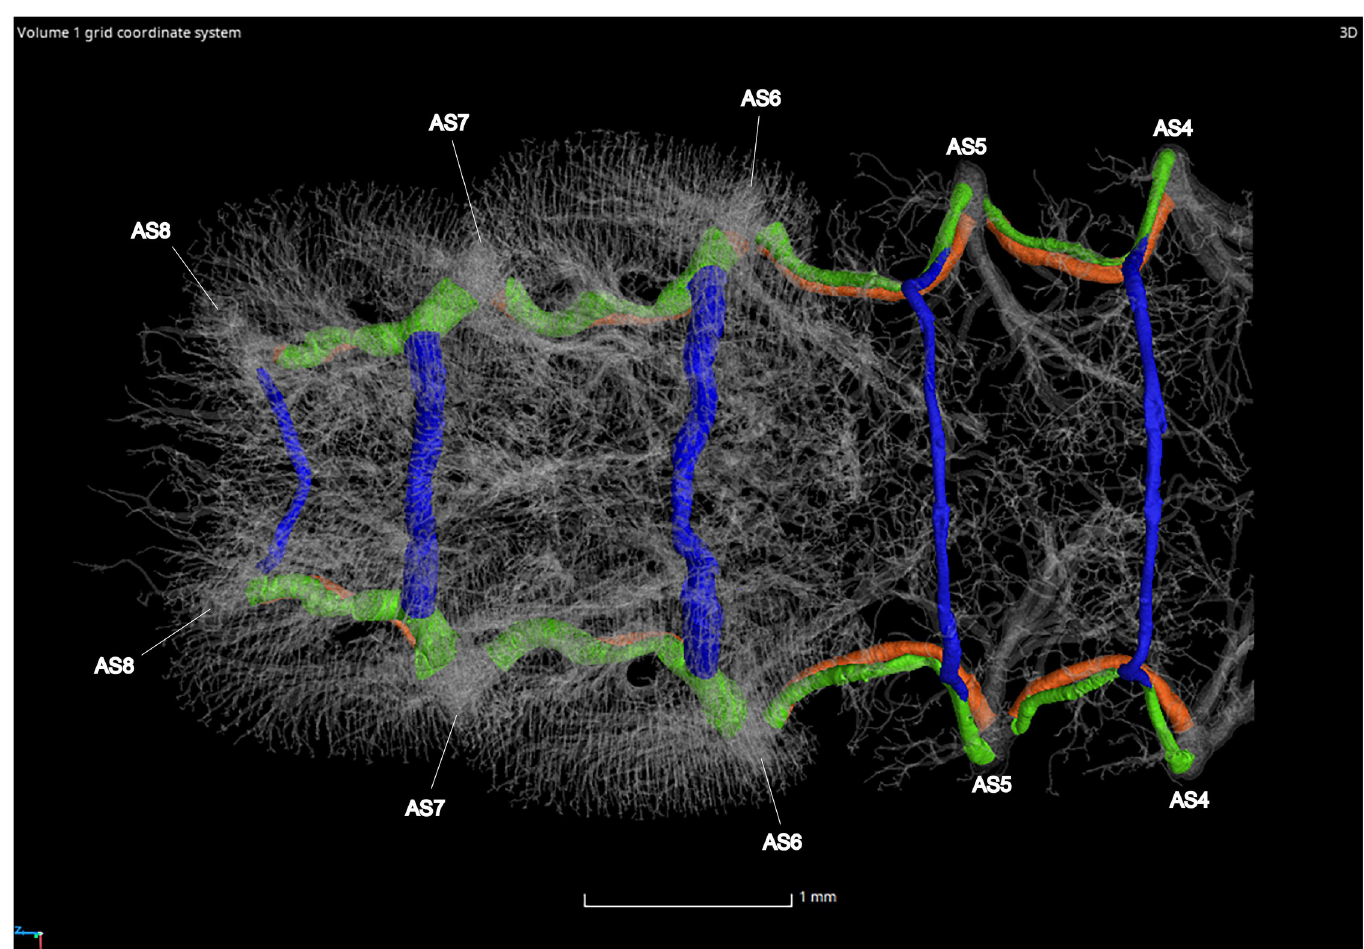
Fig 24. Ventral view of the adult male Photinus pyralis tracheal system. Ventral commissures (VC; blue), dorsal longitudinal trunks (DLT; orange), and ventral longitudinal trunks (VLT; green) highlighted for volumetric analysis.